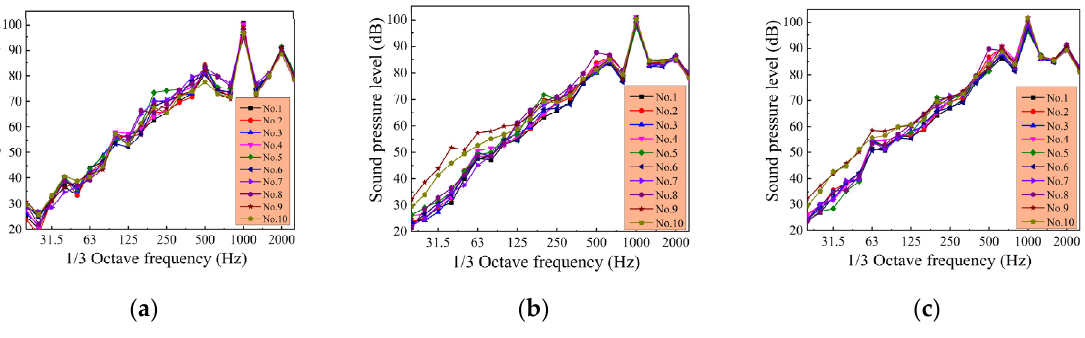
Figure 3. A-weighting sound pressure levels in one-third octave band center frequency at three speeds: ( a ) 20 km/h, ( b ) 40 km/h, ( c ) 60 km/h.